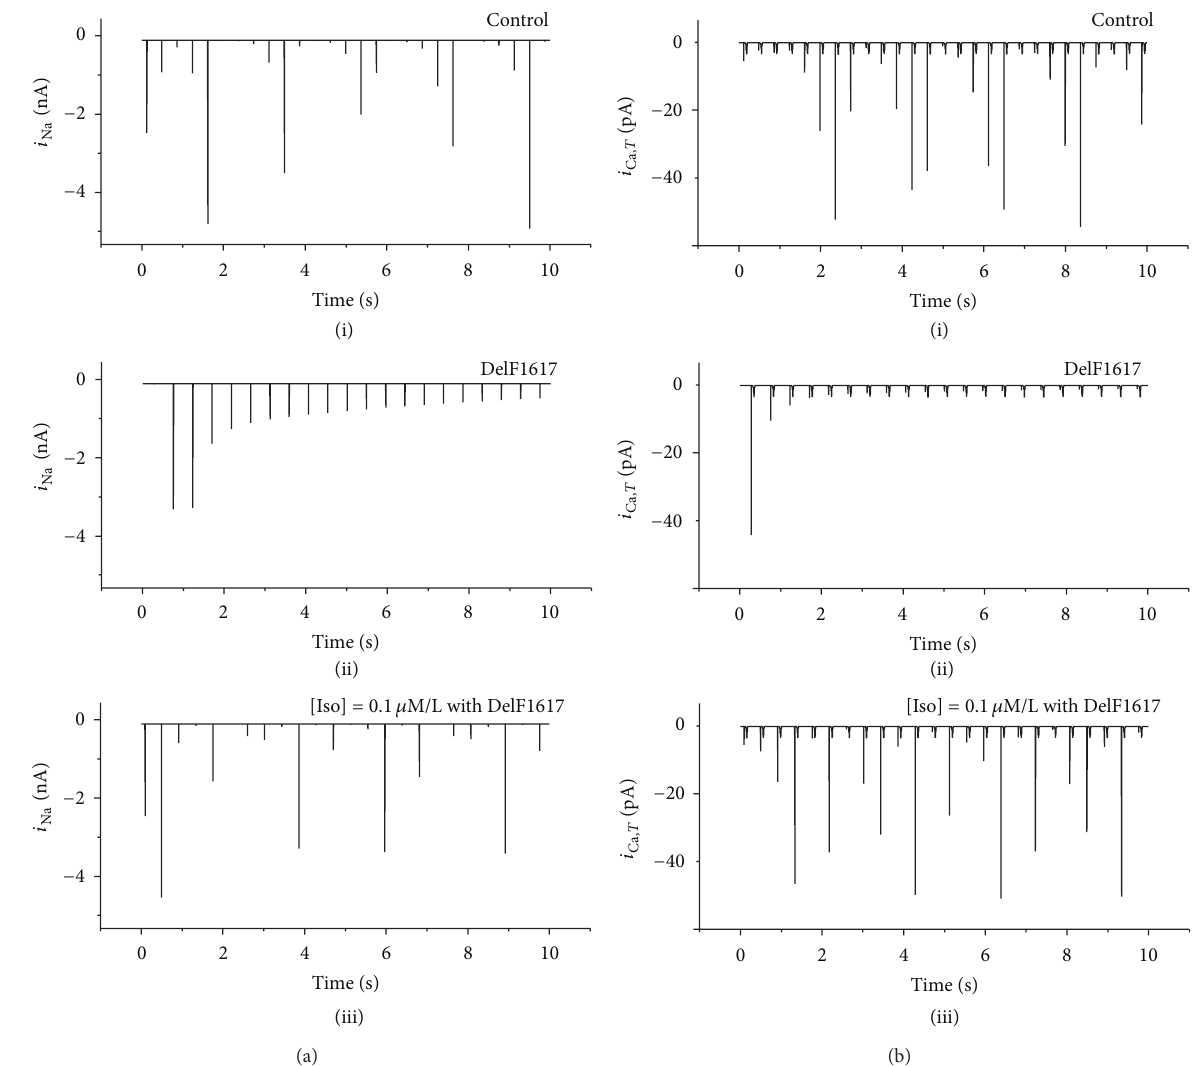
Figure 6: Time series of 𝑖 conditions (i), DelF1617 mutant channel (ii), and Iso with mutant channel (iii) are